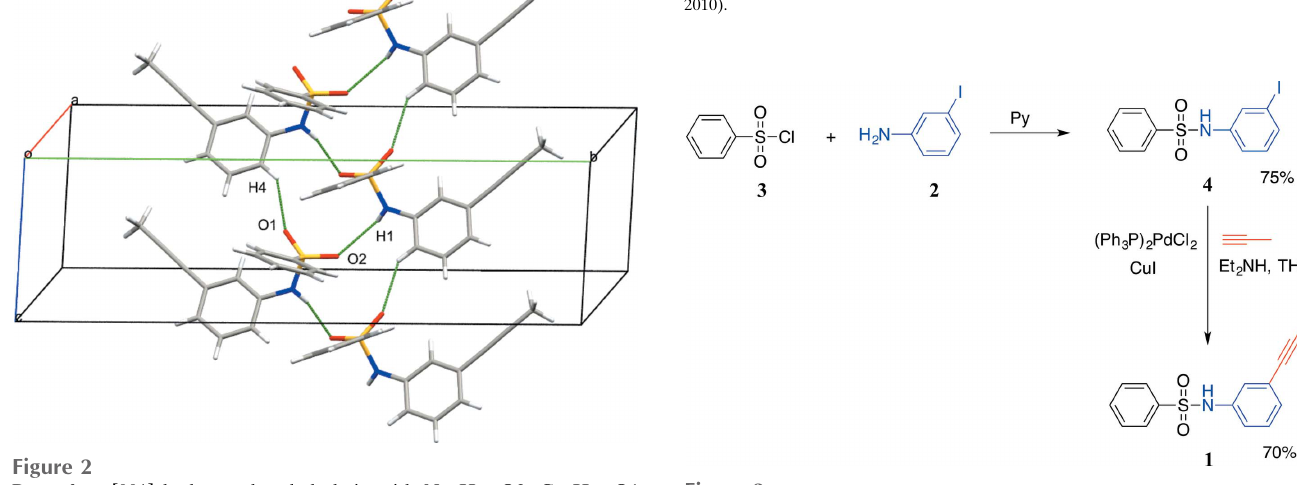
Figure 3 A synthetic scheme for the preparation of the title compound.